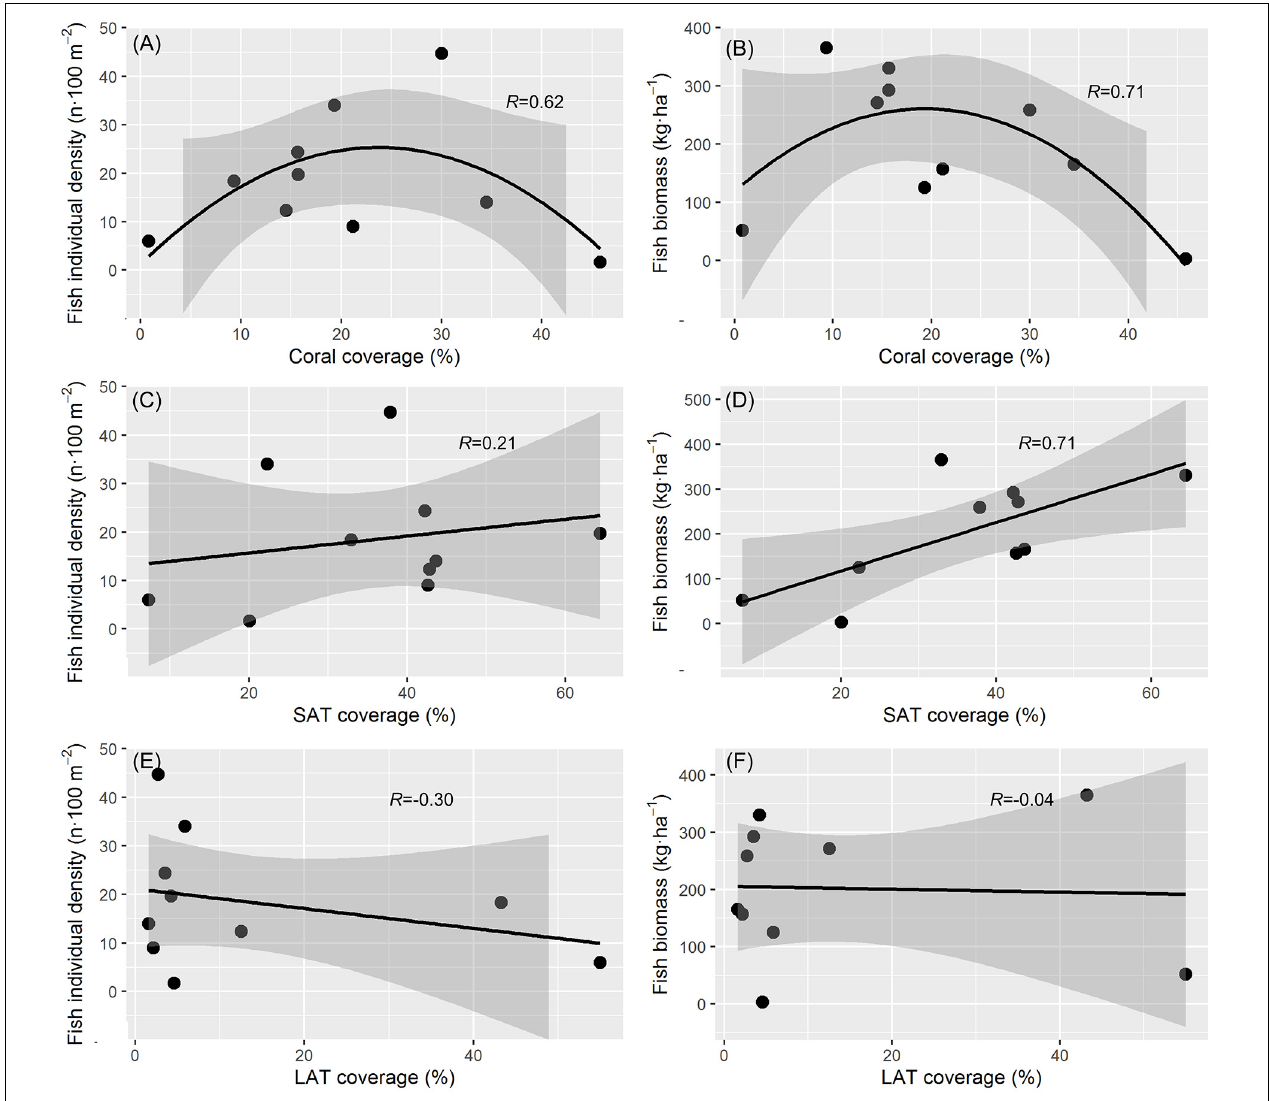
FIGURE 3 | Relationship of Ctenochaetus striatus with benthic conditions. Hard living coral coverage and (A) individual abundance, ( p = 0.18) (B) biomass ( p = 0.08) of C. striatus . The linear relationship between short algal turfs (SATs) coverage and (C) individual abundance ( p = 0.56) and (D) biomass of C. striatus ( p = 0.02). The linear relationship between SATs coverage and (E) the individual abundance ( p = 0.40) and (F) biomass of C. striatus ( p = 0.91).